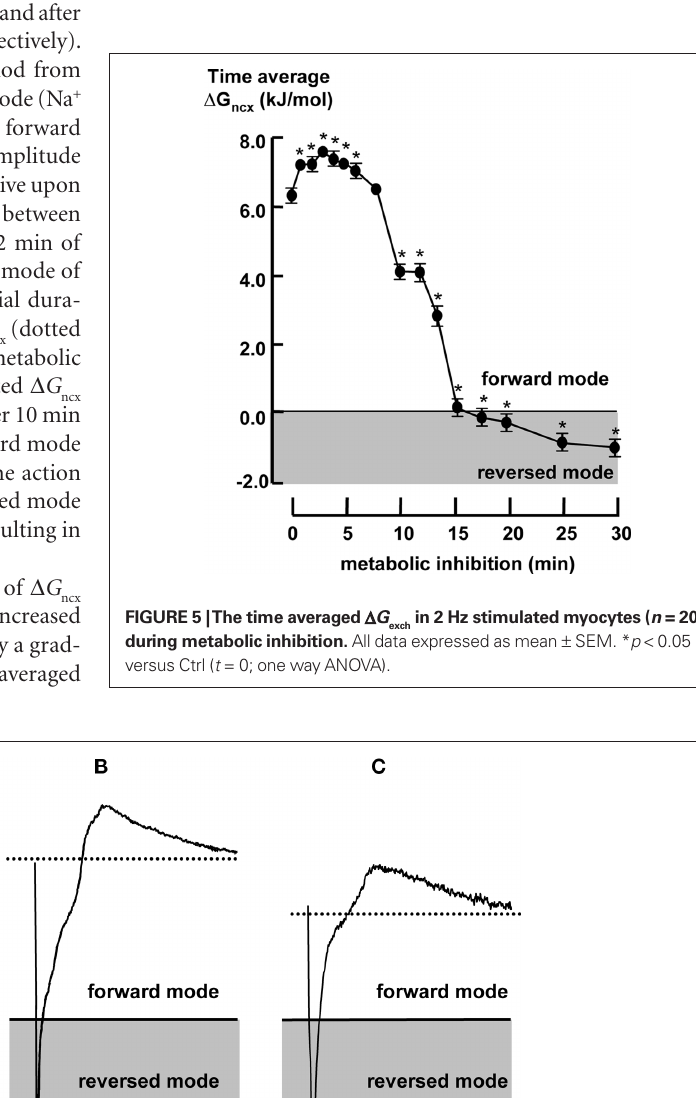
in 2 Hz stimulated myocytes during one stimulation cycle, under aerobic condition ncx